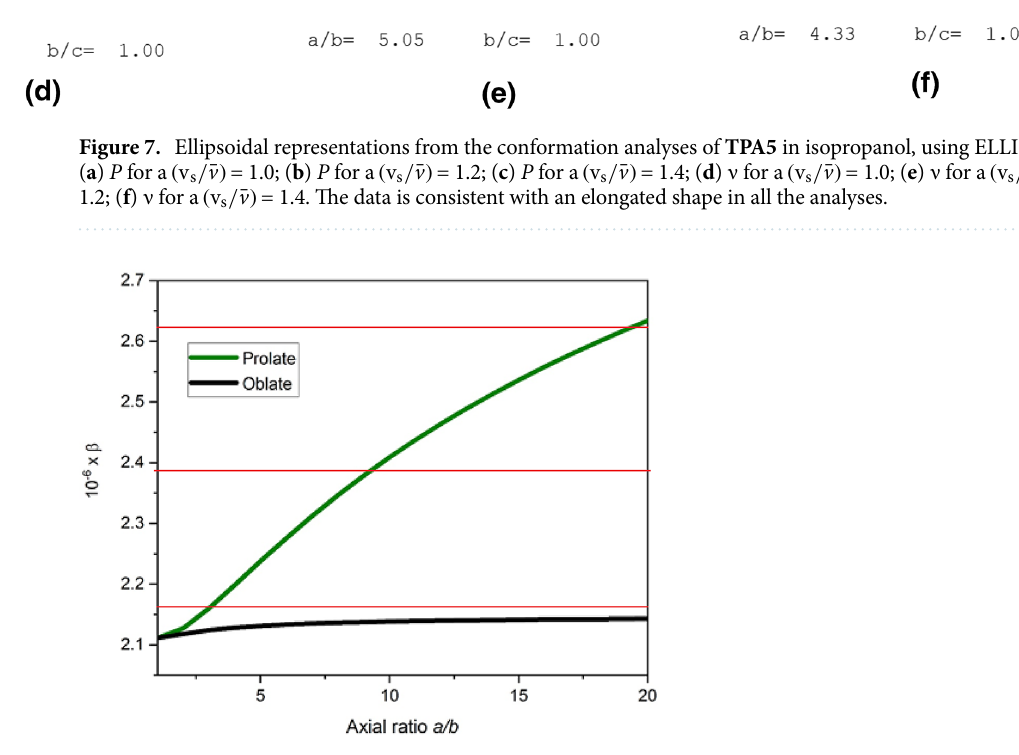
Figure 8. A plot of Scheraga-Mandelkern β function versus axial ratio with the green and black lines representing prolate and oblate shapes respectively. Red lines correspond to the experimental value of β = (2.39 ± 0.23) × 10 6 which excludes an oblate (disc)